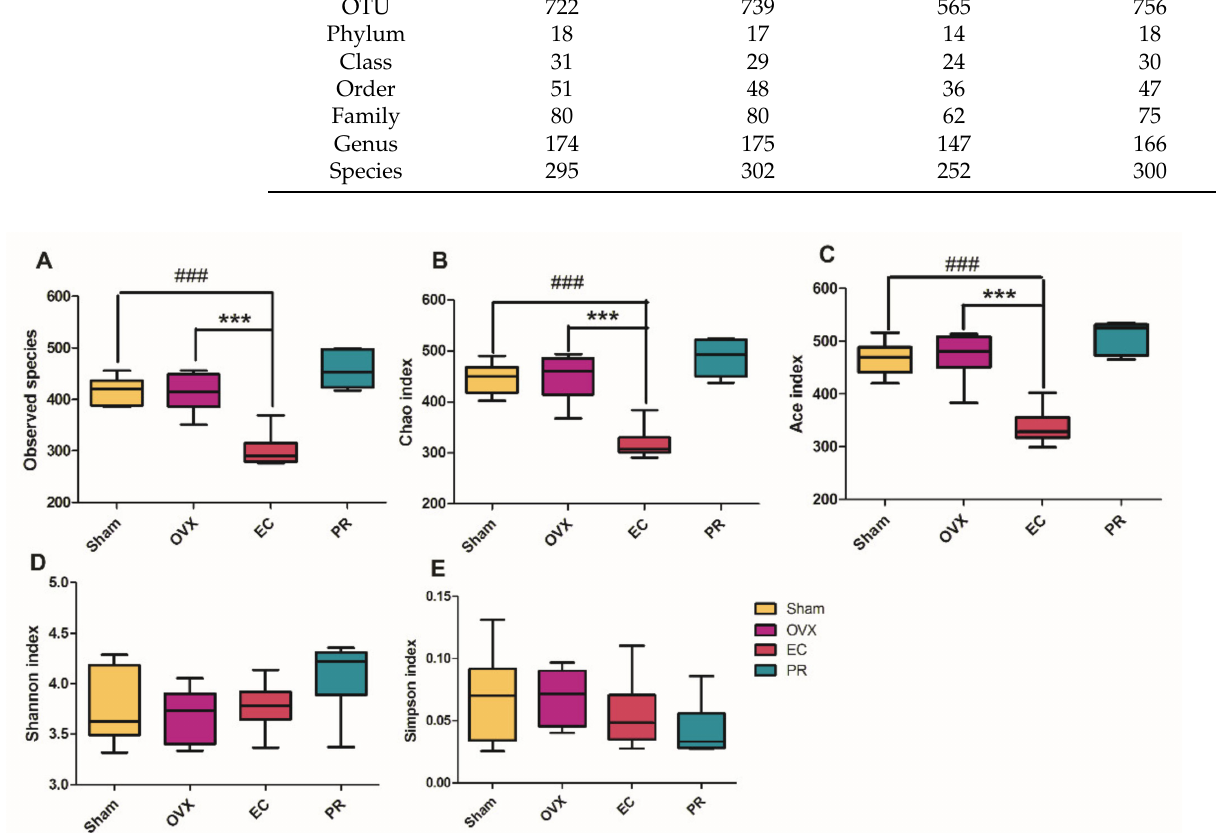
Figure 2. Changes in fecal microbial diversities upon different treatments measured by α -diversity on observed operational taxonomic unit (OTU). ( A ) Observed species; ( B ) Chao index; ( C ) Ace index; ( D ) Shannon index; ( E ) Simpson index. Statistical analysis was performed by one-way analysis of variance (ANOVA) followed by Tukey’s post-hoc test ( n = 6), and ### p < 0.001 vs. Sham; *** p < 0.001 vs.